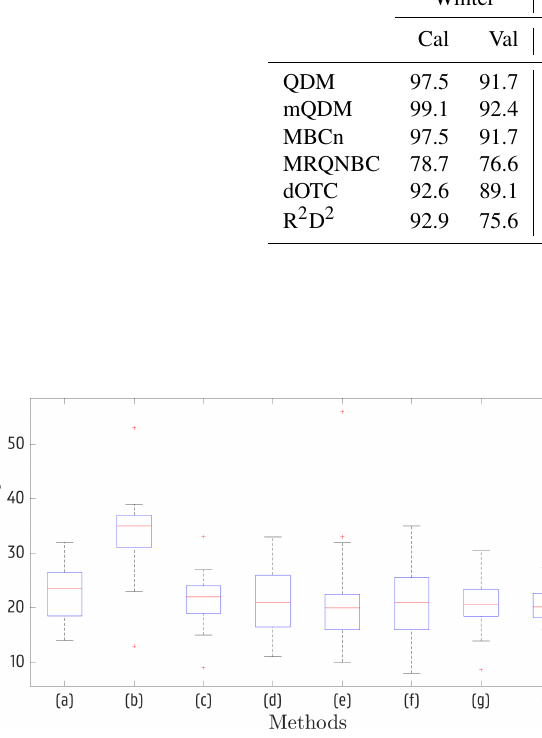
Figure 3. Box plot of the annual number of days with precipitation higher than 10mm (ETCCDI “heavy precipitation” days; see Zhang et al., 2011) in the validation period. (a) Observations, (b) raw simu- lations, (c) QDM, (d) mQDM, (e) MBCn, (f) MRQNBC, (g) dOTC, (h) R 2 D 2